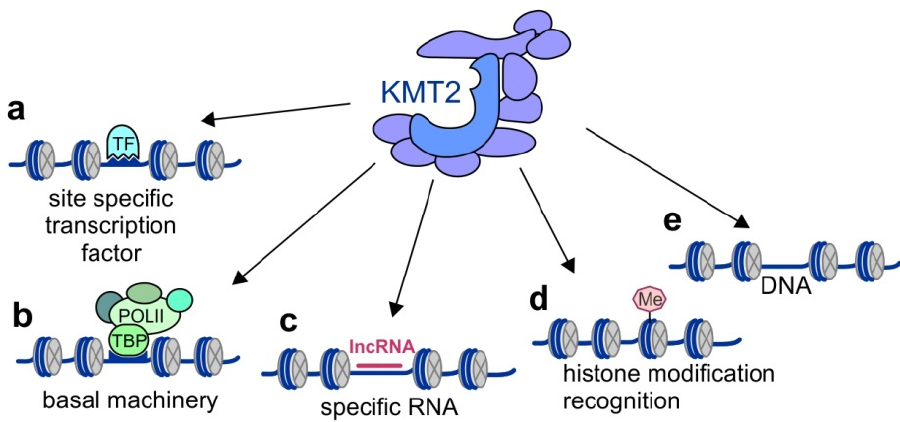
Figure 3. Mechanisms of H3K4 methyltransferase recruitment to chromatin. KMT2 complexes are recruited and stabilized on chromatin by a combination of mechanisms: ( a ) interactions with sequence-specific transcription factors, ( b ) association with the basal transcriptional machinery, ( c ) interaction with long noncoding RNAs (lncRNAs), ( d ) recognition of histone modification, and ( e ) direct interaction with DNA. For references, see the text.